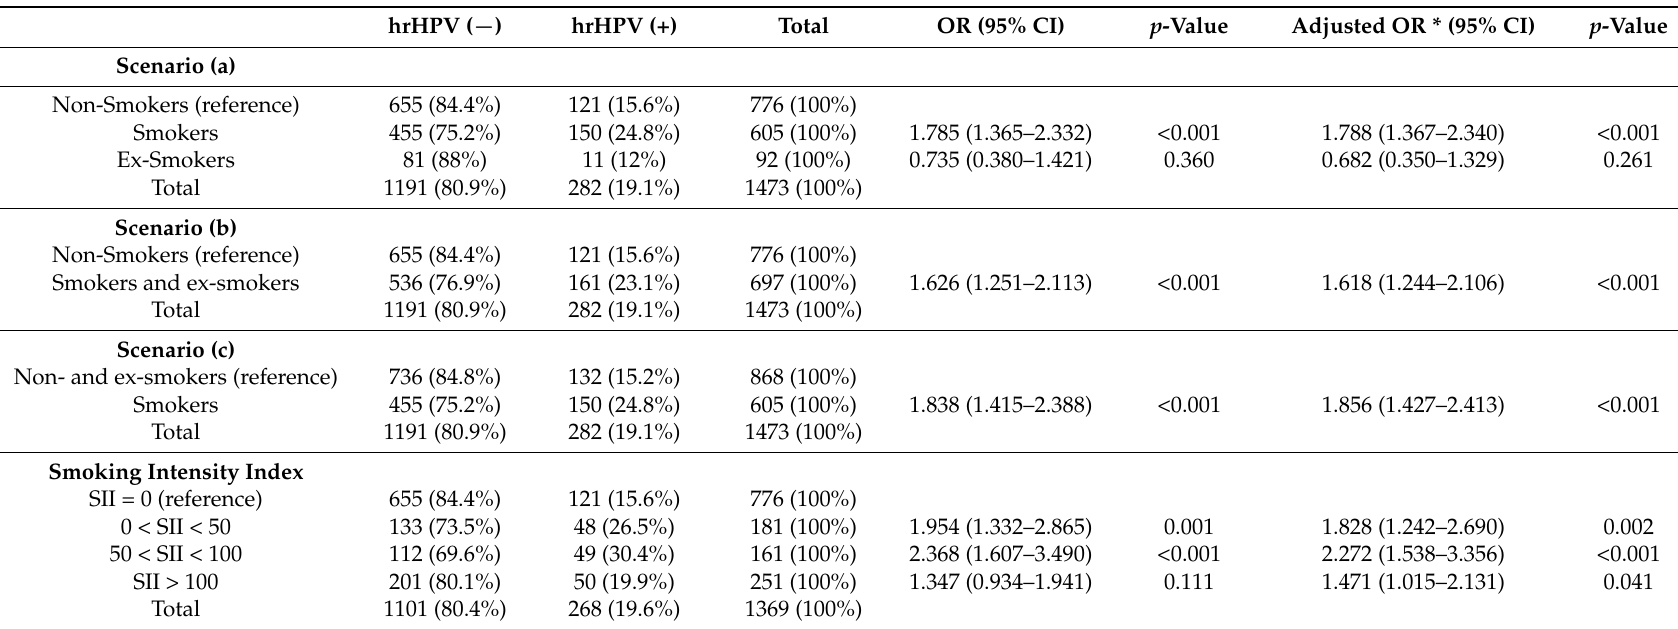
Table 2. Association between smoking and high-risk human papillomavirus status. The cross-tabulation tables are displayed per horizontal panel along with the odds ratios (95% CI) and the corresponding p -values (binary logistic